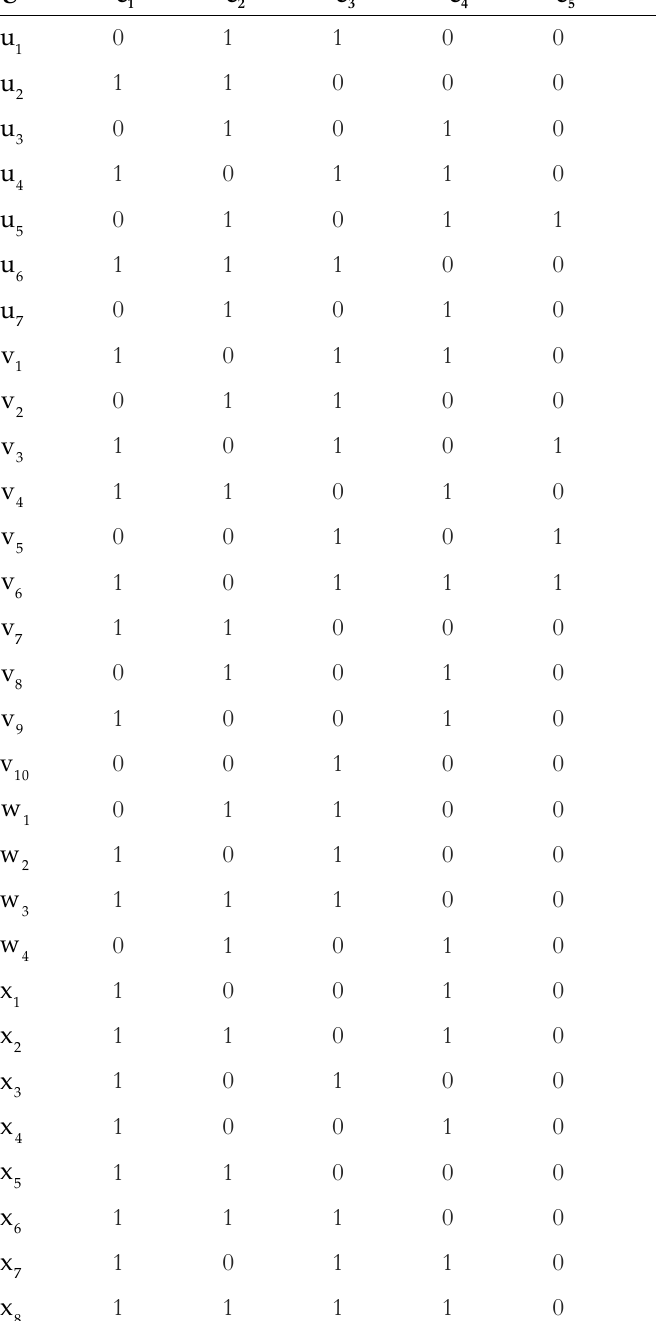
Table 3. Tabular representation for the given soft set (F,